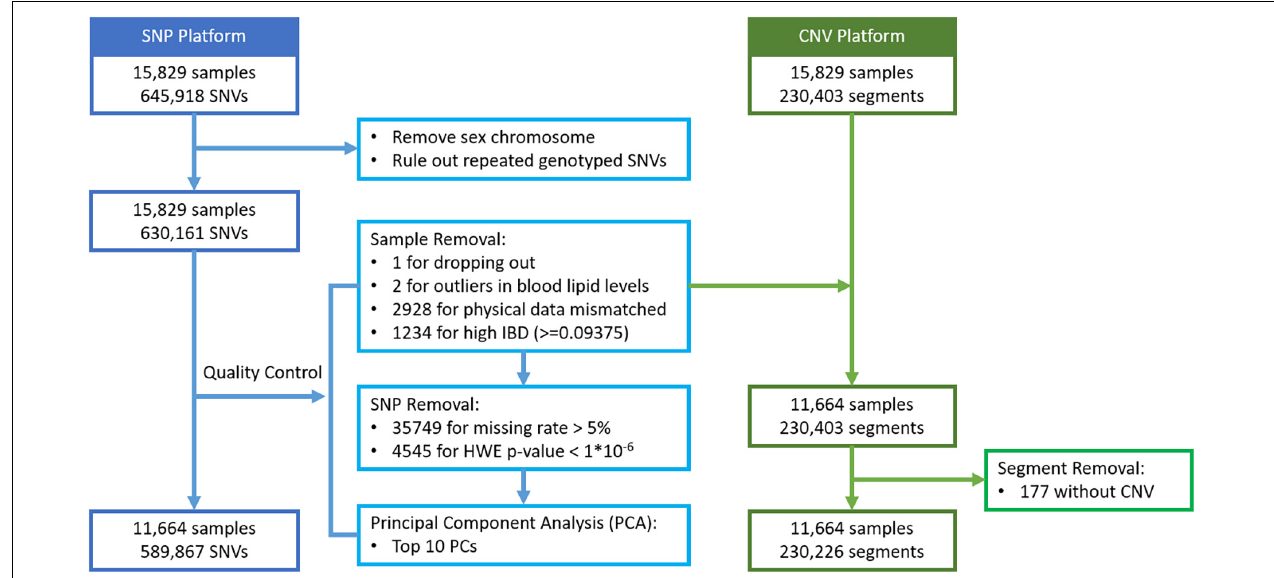
FIGURE 3 | Flowchart of genomic data management for Taiwan Biobank